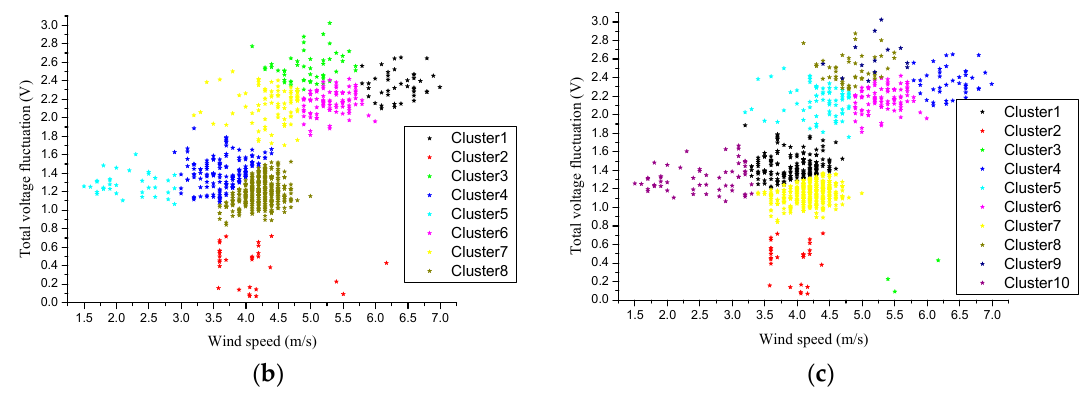
Figure 7. Clustering results with different k values. ( a ) k = 6; ( b ) k = 8; ( c ) k = 10. When k = 6, it can be seen from Figure 7a that the 807 5-dimensional data points are divided into six clusters. Cluster 1 is the black data point set in the graph, which has the characteristics of 3~5 m/s wind speed and 1.7~2.5 V total voltage fluctuation. Cluster 2 is the red data point set in the figure, which has the characteristics of more than 3.5 m/s wind speed and 0~0.8 V voltage fluctuation. Cluster 3 is the green data point set in the graph. This cluster has the characteristics of wind speed greater than 5 m/s and the voltage fluctuation greater than 2 V. Cluster 4 is the dark blue data point set in the picture, and it is also the most abundant cluster and is the state that occurs most often. The wind speed of cluster 4 is 3.5~4.5 m/s, and the voltage fluctuation is normal 1~1.7 V. Cluster 5 is the light blue data point set in the figure. The wind speed of the cluster is less than 3.5 m/s and the voltage fluctuation is between 1~1.7 V. Cluster 6 is the red data point set in the graph. The cluster has the characteristics of voltage fluctuation greater than 2.2 V and wind speed of 4~5.5 m/s. Therefore, after clustering, data points with the same characteristics of wind speed and voltage fluctuation are clustered into the same cluster. When k = 8, as shown in Figure 7b, clusters 1, 3, and 6 in Figure 7a are subdivided into 4 clusters. The cluster 4 and 5 in Figure 7a are subdivided into three clusters. And when k = 10, as is shown in Figure 7c, the cluster 2 in Figure 7b is further subdivided into two clusters, clusters 2 and cluster 3 respectively. There are only three points in cluster 3, and the voltage fluctuation is less than 0.4 V, which can be considered as the abnormal data point. These points are filtered out and ignored in subsequent correlation analysis under minimal support condition. In addition, the cluster 9 in Figure 7b is further subdivided into clusters 8 and 9 in Figure 7c, and the range of cluster 8 and 9 is intersected. The wind speed, three-phase voltage fluctuation and total voltage fluctuation are considered in the clustering, but the subdivision is not necessary in terms of the total voltage fluctuation and wind speed. Therefore, nine clusters scene is likely to be the best case from the clustering result. The data is clustered again with k = 9 and the clustering results are shown in Figure 8.